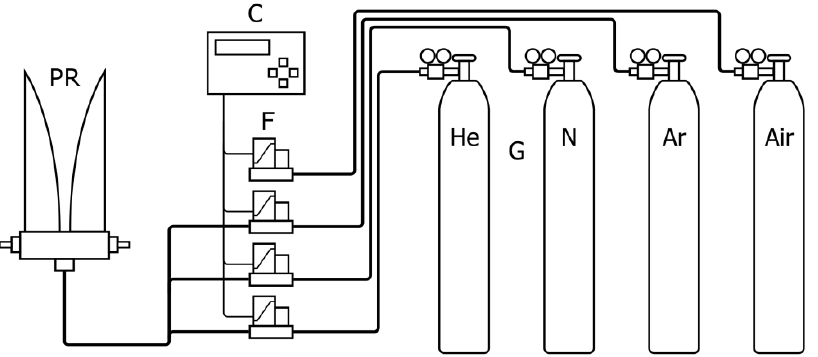
Figure 7. Plasma gas supply system, PR—plasma reactor, G—plasma gases, F—flow regulators, C—regulator setting and control system.